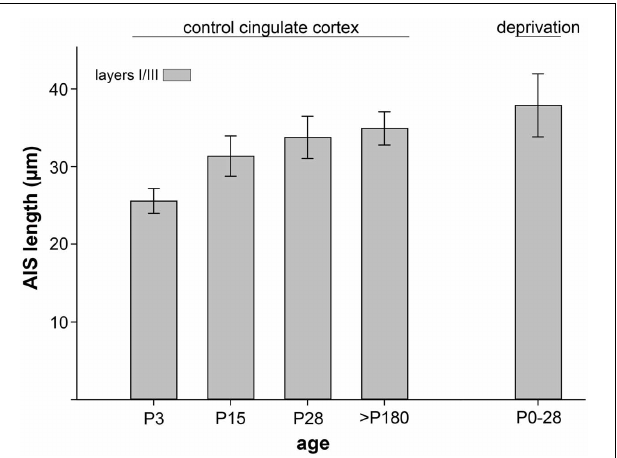
FIGURE 4 | AIS length maturation in a non-visual, non-sensory cortical region, the cingulate cortex. AIS length of layer II/III neurons increased moderately during postnatal development and reached mature measurements after the peak of the CP (P28). No significant ( p > 0 . 1) tri-phasic length maturation was observed in at least 100 AIS per cortex in 3 animals. As a control for dark-rearing experiments, the far right bar indicates no significant length changes after a 4 week deprivation period.